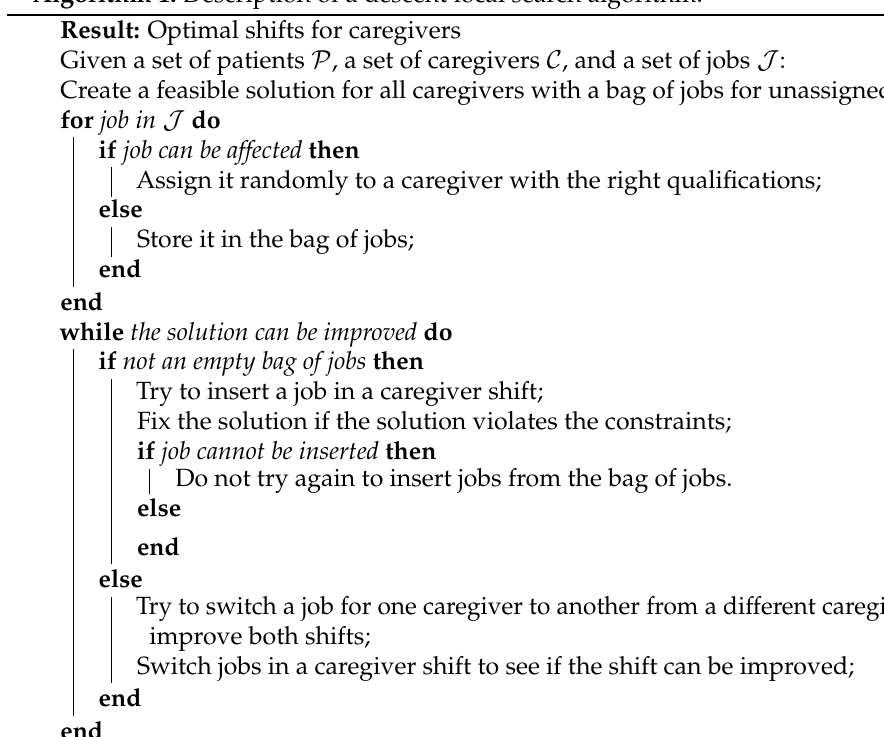
Figure 9. Bag of neighborhood moves. Algorithm 1: Description of a descent local search algorithm.